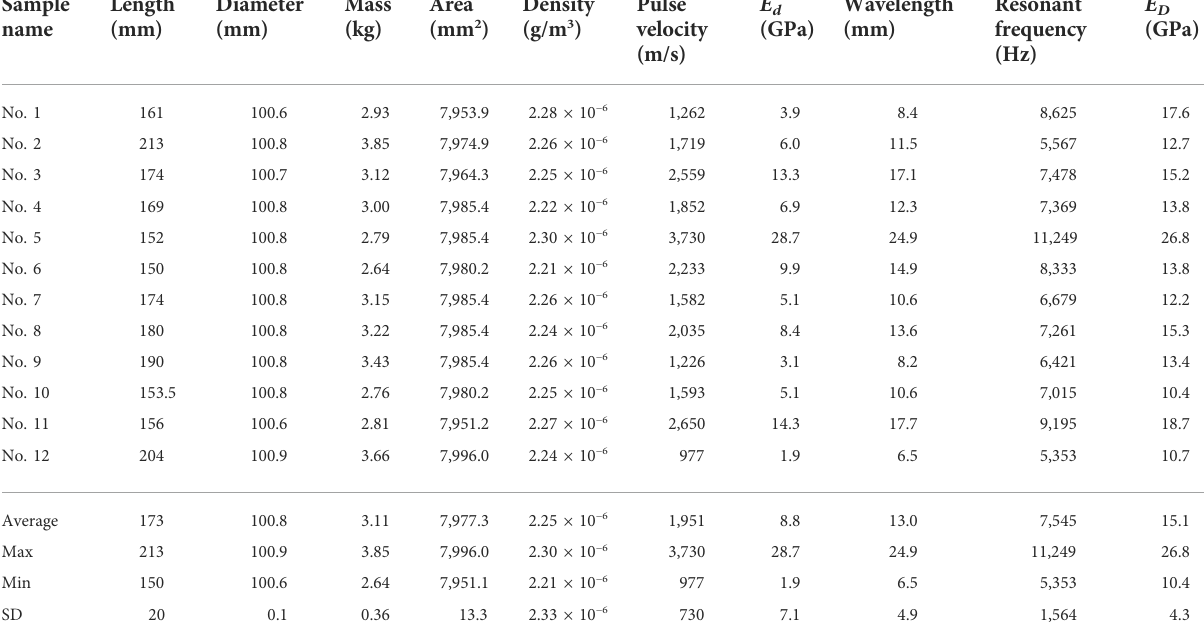
TABLE 3 Physical properties of testing concrete